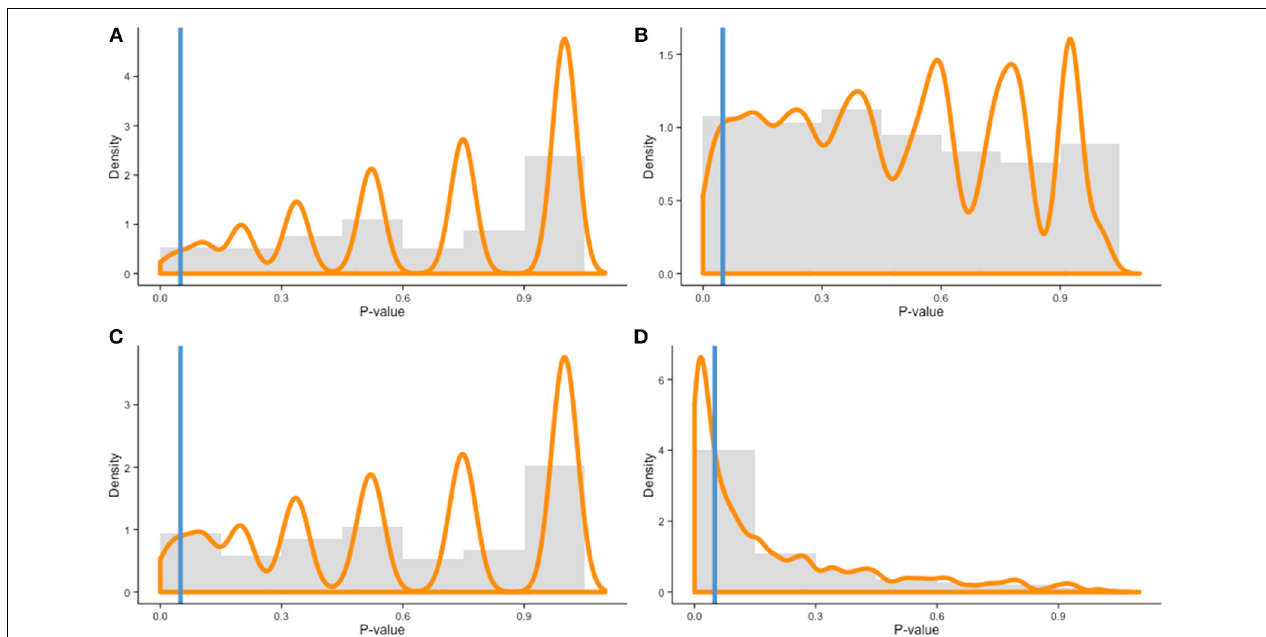
FIGURE 1 | Distributions of χ -squared contingency table test p -values for a Monte Carlo simulation with 10,000 draws of two samples ( N = 20 per cell) in four different scenarios: (A) 2 subpopulations—Equal ratios, (B) 3 subpopulations—Equal ratios, (C) 2 subpopulations—Unequal